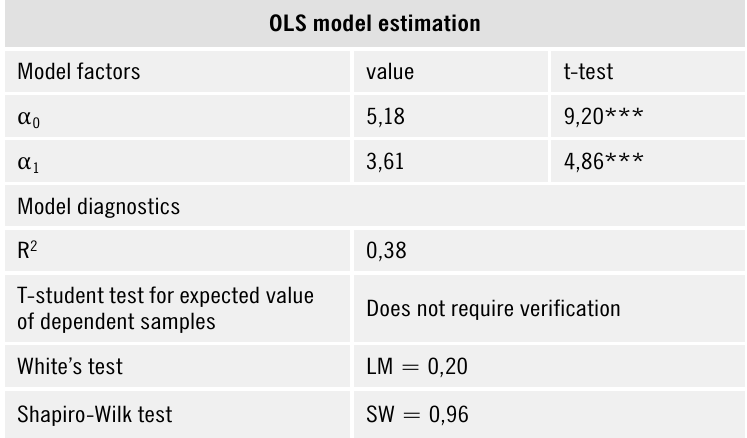
Spearman’s rank correlation t-test coefficient